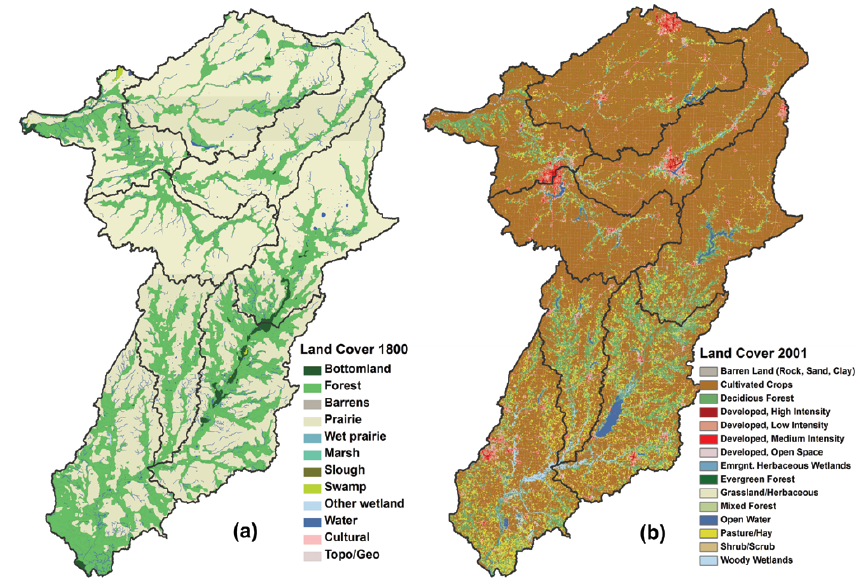
Fig. 1. Land cover change in two watersheds in central IL: pre-European settlement land cover (a) and present-day (b)